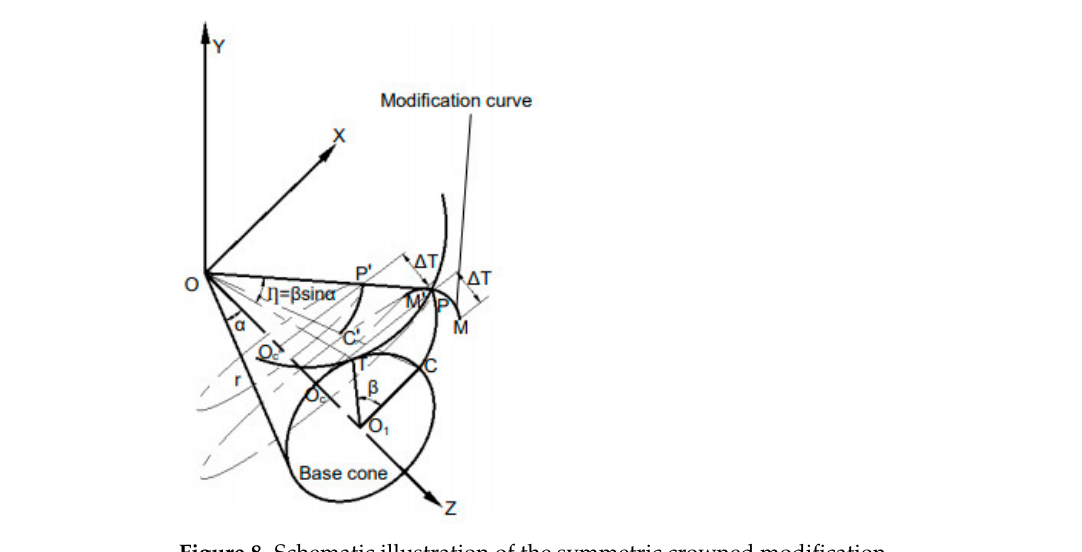
Figure 8. Schematic illustration of the symmetric crowned modification.